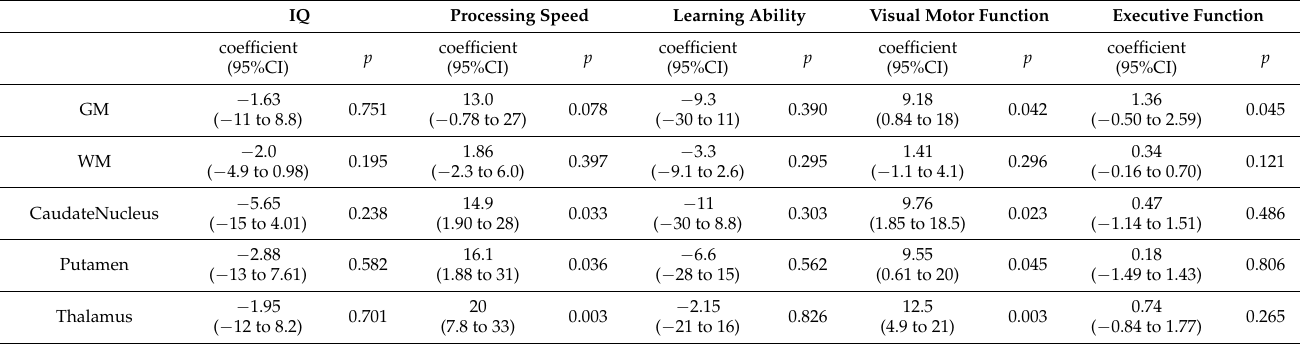
Table 3. Association between CBF and cognitive domains in entire